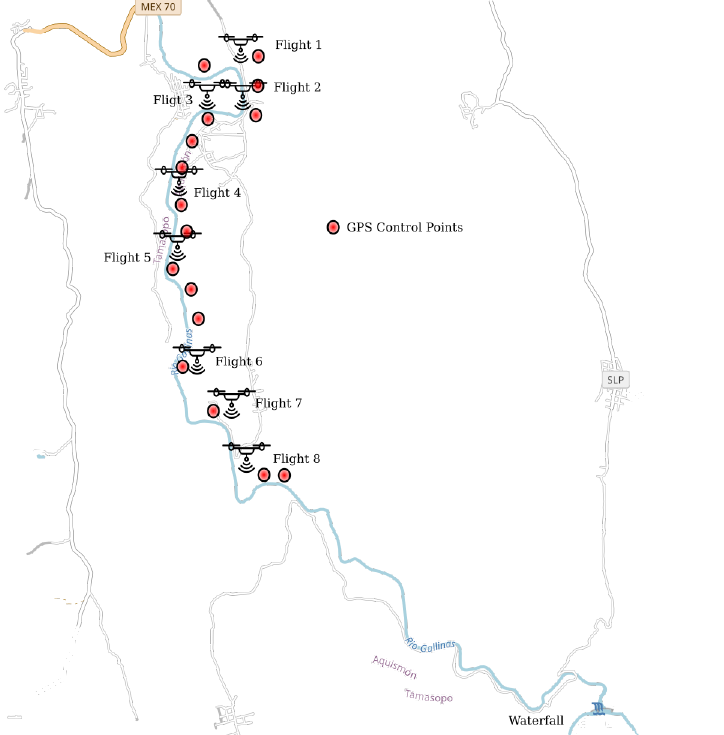
Figure 3. Location of the flights performed to determine the topographic survey and demarcation of the